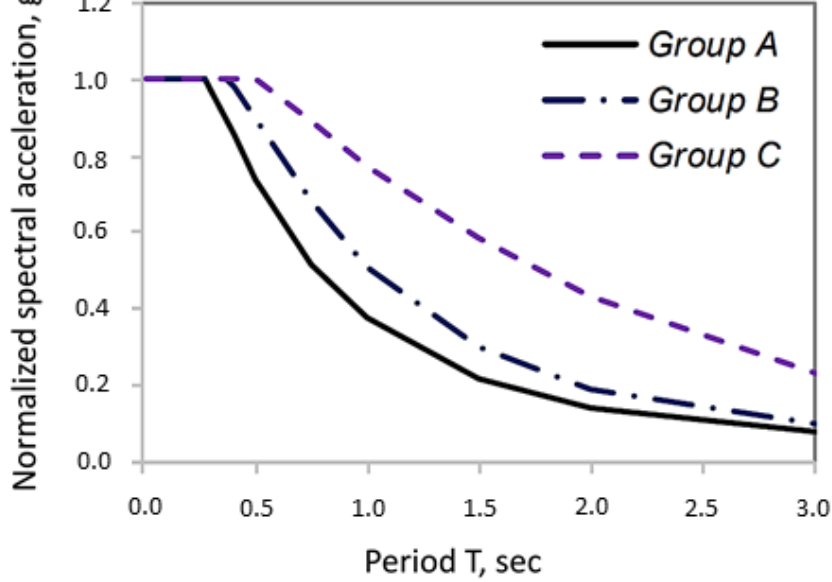
Figure 3. Normalized response spectra for 3 categories/groups of assets A, B and